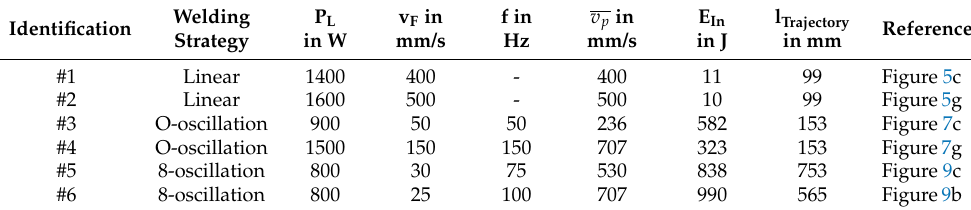
Table 5. Compilation of metallographically approved process parameters developed for different overlap welding strategies from copper to aluminum (repetition and extension of Table 4).